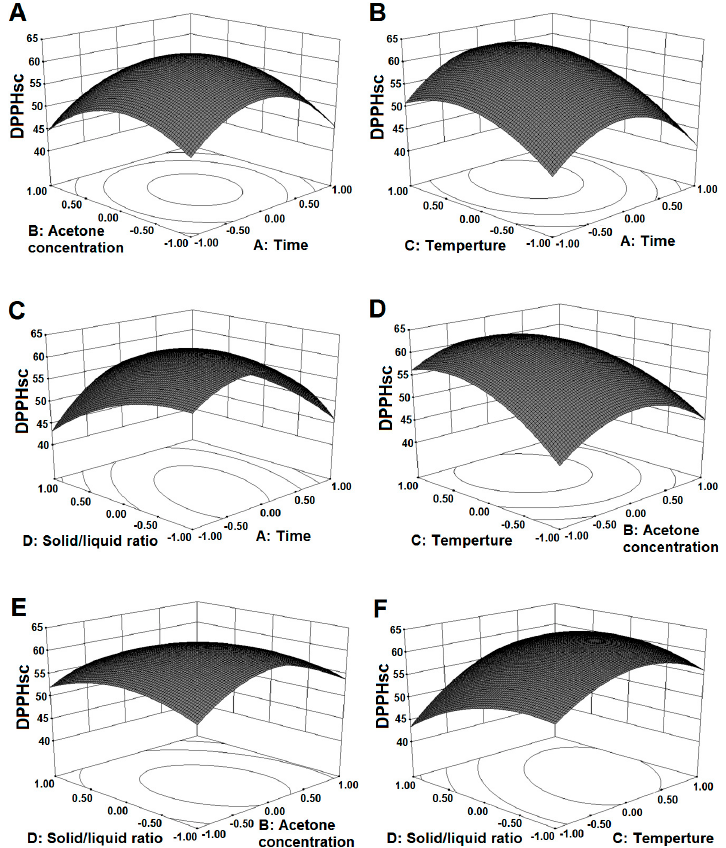
Figure 2. Response surface plots for the effect of acetone concentration and time ( A ); temperature and time ( B ); solid/liquid ratio and time ( C ); temperature and acetone concentration ( D ); solid/liquid ratio and acetone concentration ( E ) and solid/liquid ratio and temperature ( F ) on the DPPH radical scavenging activity of KSP.